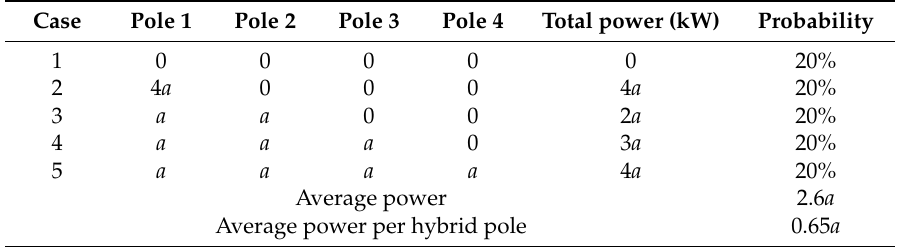
Table 4. Average power of 4 hybrid poles under the condition of uniform